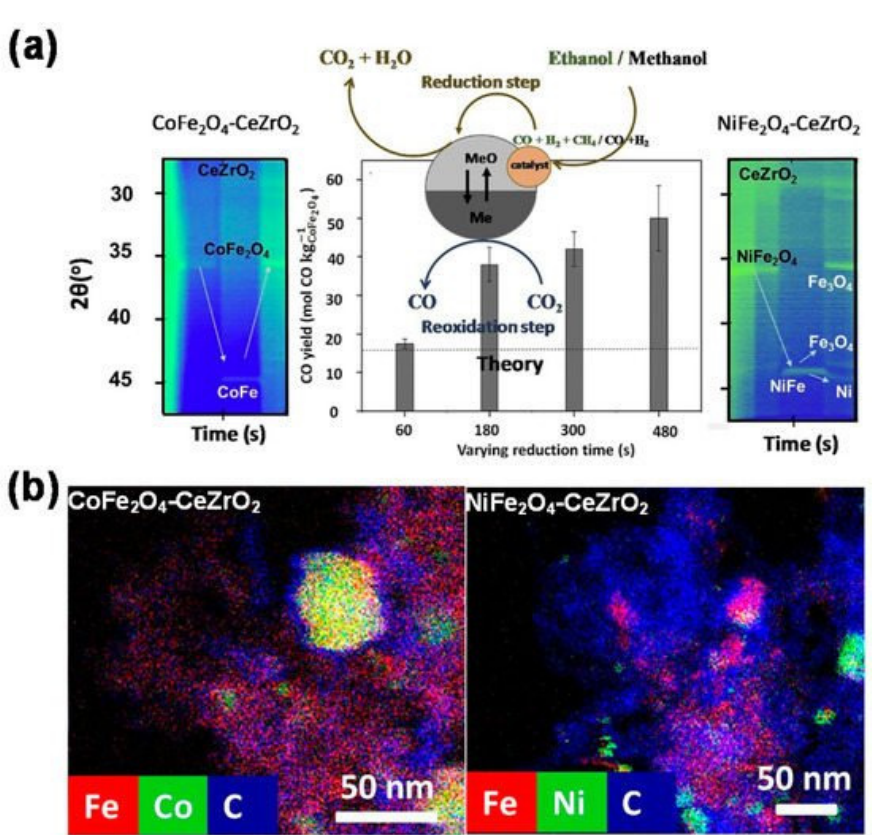
Figure 9. Bifunctional Co- and Ni-ferrites modified with CeZrO 2 for chemical looping dry reforming with alcohols as feed: ( a ) Transformation of solid and gaseous phases, ( b ) elemental maps of Co, Ni, Fe and C in 20 wt% CoFe 2 O 4 -CeZrO 2 and NiFe 2 O 4 -CeZrO 2 after methanol redox cycles [55].